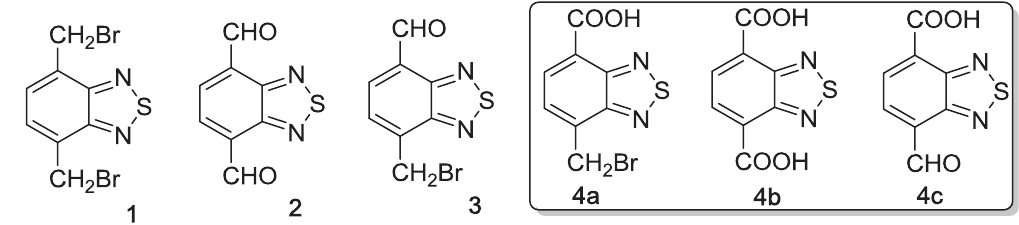
Figure 1: Structure of 2,1,3-benzothiadiazole